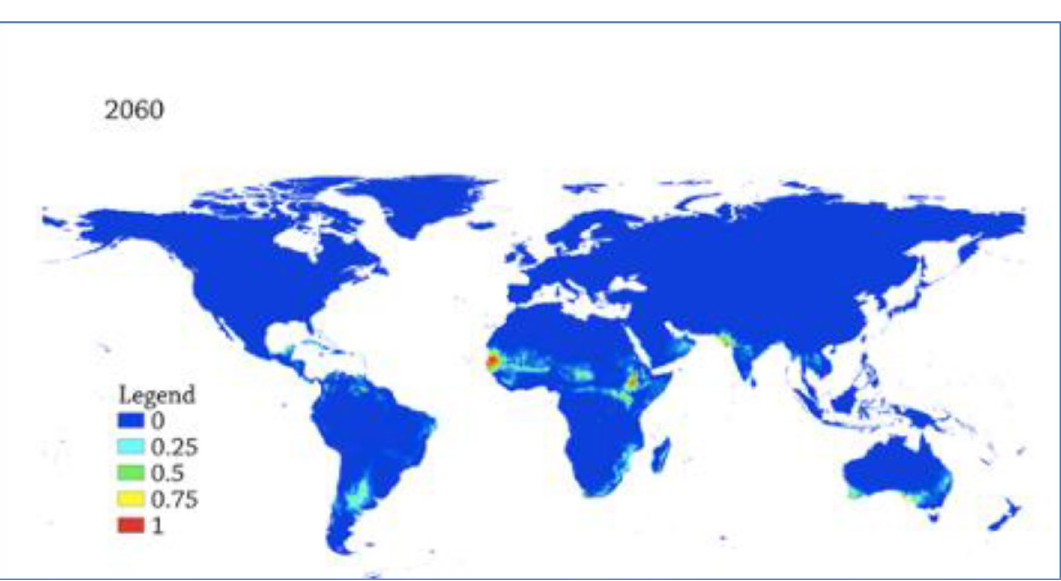
Figure 6. Predicted future global distribution gradient of AHS in from 2040 to 2060. The warmer colors depict suitable areas while the cooler colors depict unsuitable